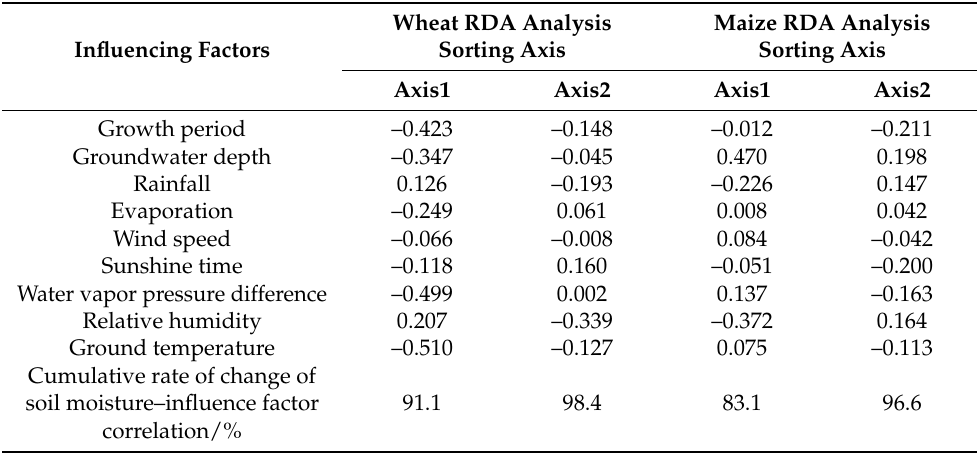
Table 5. Correlation coefficients between influencing factors wheat and maize land and the first 2 axes of the RDA analysis